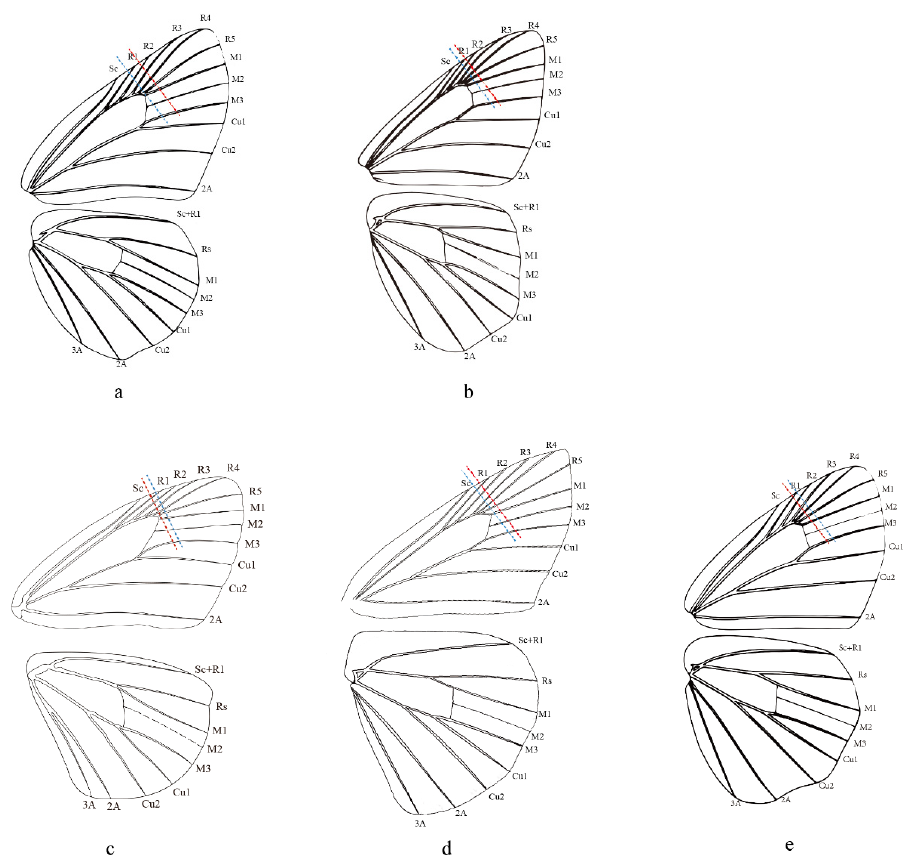
Figure 5. Wing venation of ( a ) Tagiades vajuna , ( b ) Caplia omeia , ( c ) Celanorrhinus maculosus , ( d ) Saranges dasahara , and ( e ) Pseudocoladenia dan . The blue dashed line denotes the length of the dorsun, and the red dashed line denotes 2/3 the length of the costa. ( a , b , e ) are reproduced from Chou (1998) [56].